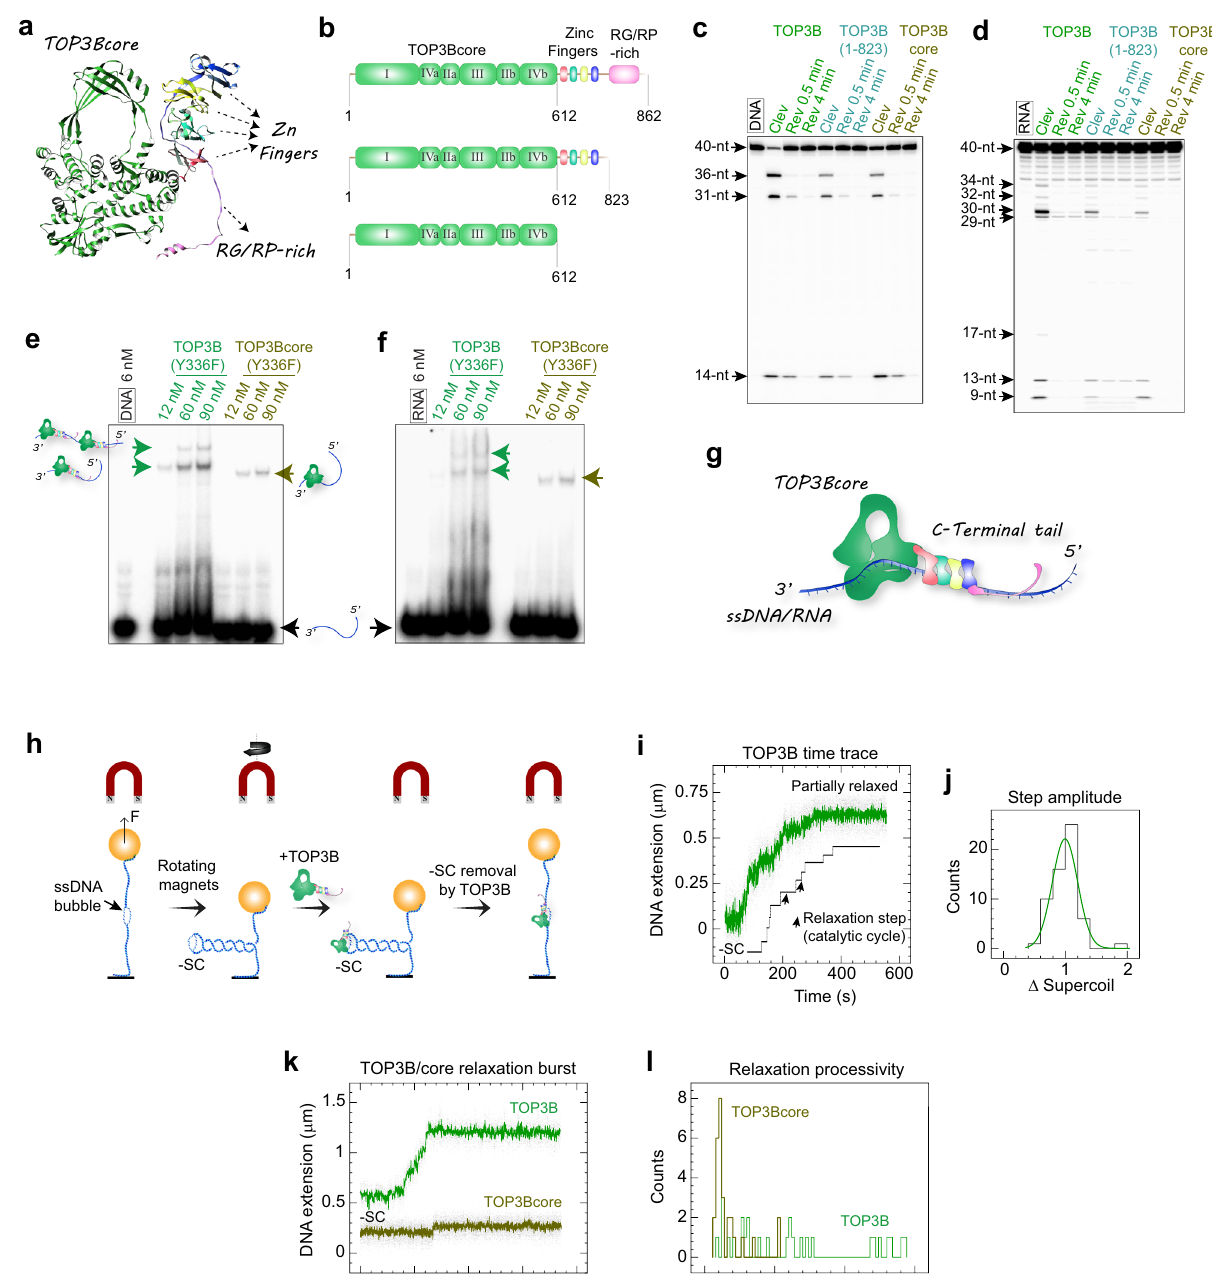
Fig. 4 | The C-terminal tail of TOP3B stimulates DNA/RNA binding and improves the catalytic processivity of TOP3B. a Overall architecture of TOP3B based on AlphaFold-predicted 3D model. The conserved TOP3Bcore is colored in green and the C4-type zinc- fi nger motifs and an Arg-Gly/Arg-Pro-rich fragment in the C-terminal tail are indicated by arrows. b Domain structures of the full-length TOP3B,oftheRG/RP-richfragmentdepletedmutantandoftheTOP3Bcore.Roman numeralsrefertotheconserveddomainsI-IVoftypicaltypeIAtopoisomerasesand numbers to amino-acid positions. c DNA cleavage and reversal assays with WT TOP3B and mutants displayed in panel b. Same molar concentrations of DNA/RNA and enzymes were tested in all the assays. Steady-state cleavage products (Clev) and high-salt reversal products (Rev) at various time points are indicated above each lane. d same as c for RNA cleavage and reversal. e , f EMSA assays using catalytic inactive TOP3B-Y336F and TOP3Bcore-Y336F showing reduced DNA and RNA binding upon C-terminal tail removal. Arrows and cartoons indicate enzyme- substrate bands. Enzyme concentrations are indicated above each lane. Each gel-